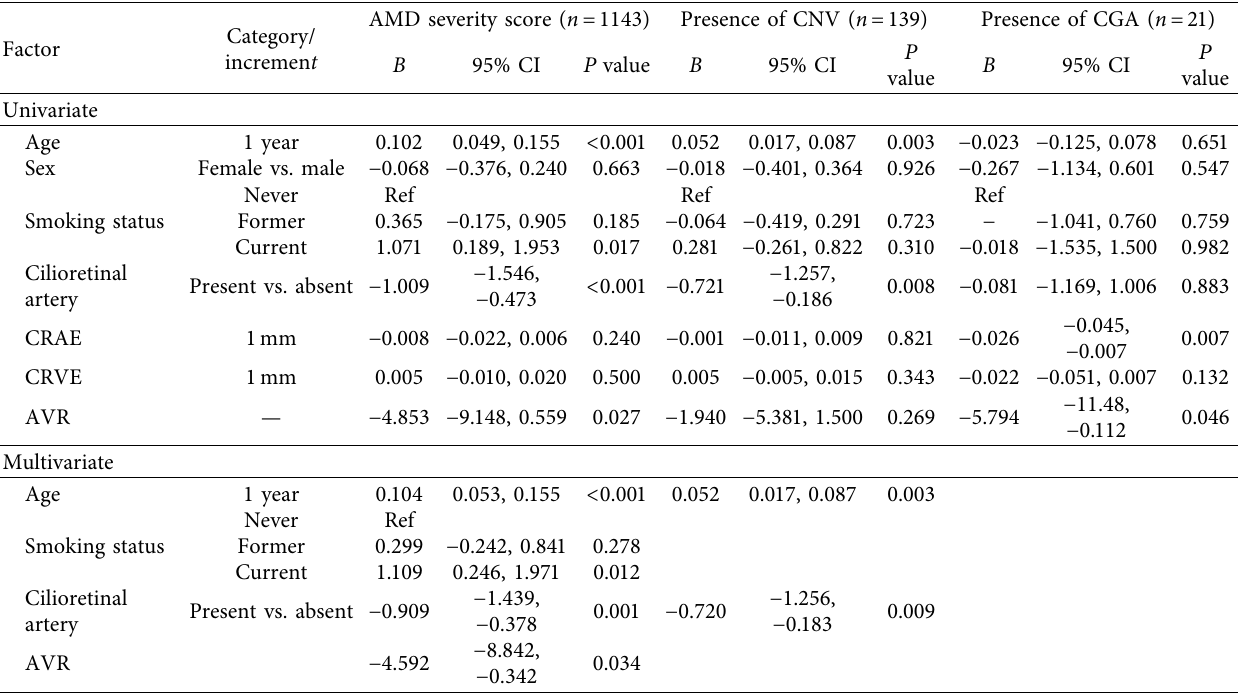
Table 3: Retinal vascular parameters associated with AMD severity.